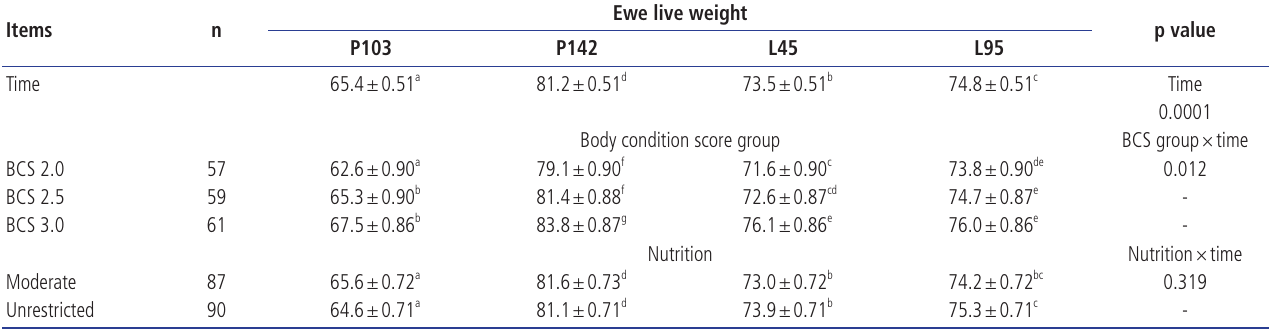
Table 1. Effect of ewe body condition score group (2.0 vs 2.5 vs 3.0) and nutritional treatment in very late pregnancy and lactation (Moderate vs Unrestricted) on ewe live weight (kg; mean±SEM) at P103, P142, L45, and L95